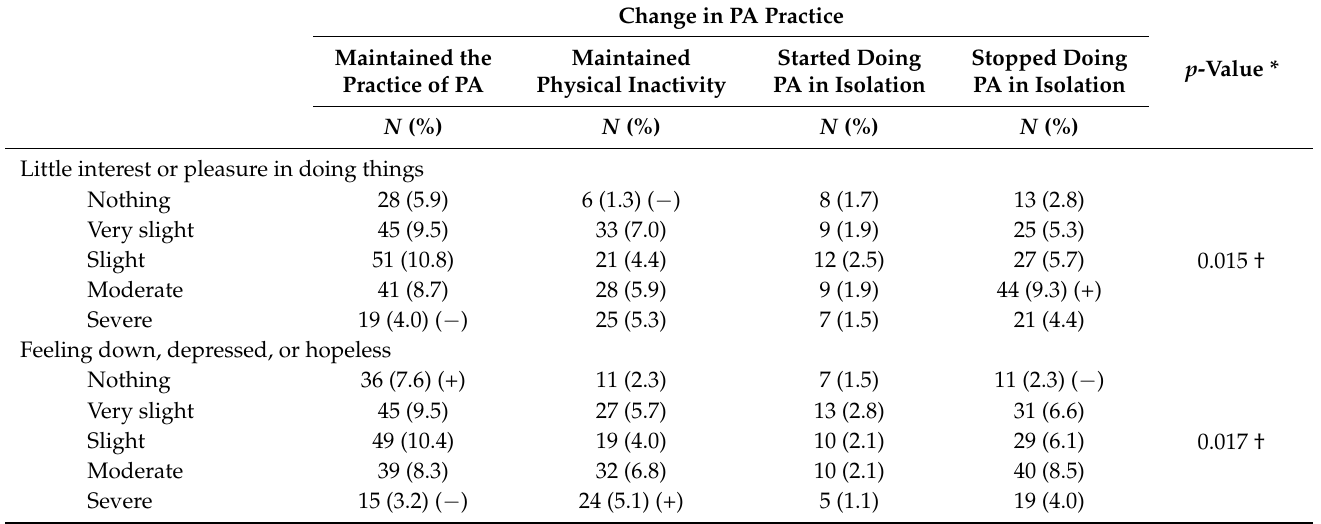
Table 2. Association between changes in the practice of physical activity and mental health in individuals with type 1 Diabetes Mellitus during social isolation in Brazil,